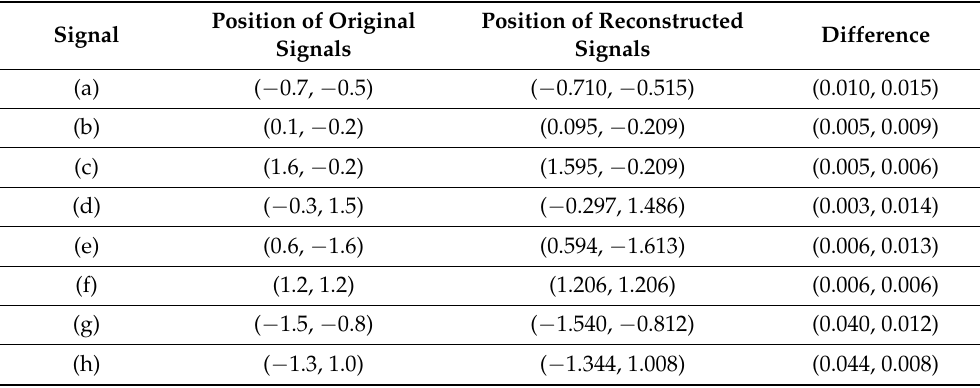
Table 4. Center positions ( x 0 , y 0 ) of the eight separated fringe patterns from Figure 3b.